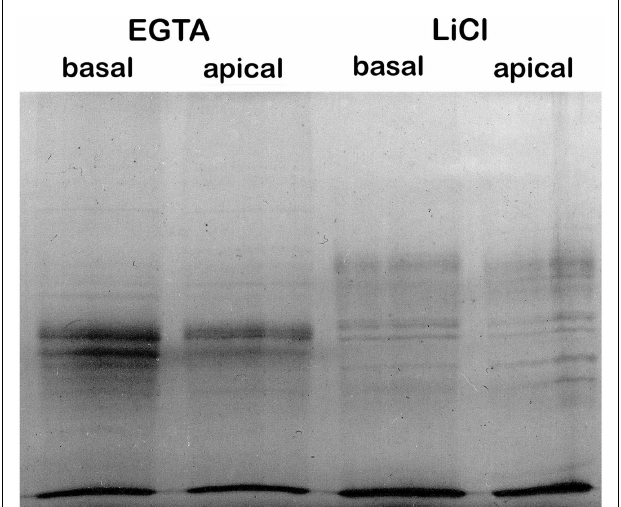
FIGURE 1 | Sequential EGTA-treatment and LiCl extraction of cell walls creates distinguishable protein